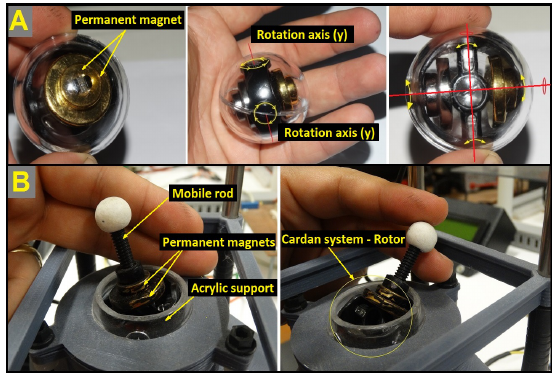
Figure 4. ( A ) Isolated view of the rotor; and ( B ) rotor with the attached rod inserted in the